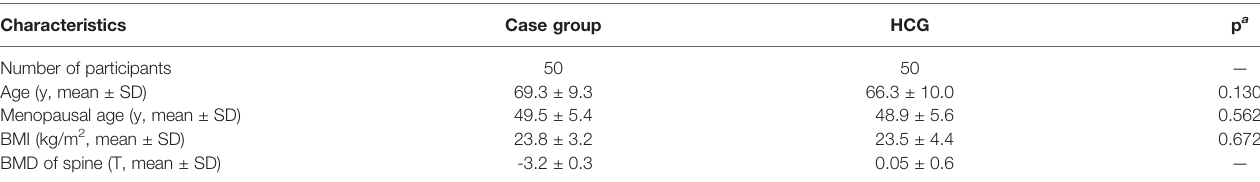
TABLE 1 | Participant characteristics at the time of